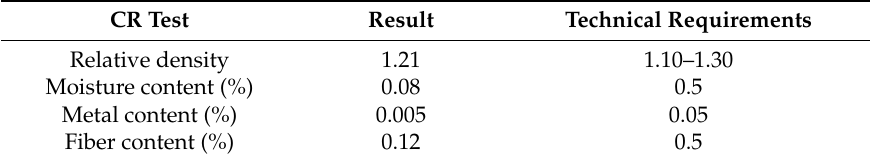
Table 3. Properties of crumb rubber (CR) used in this research.